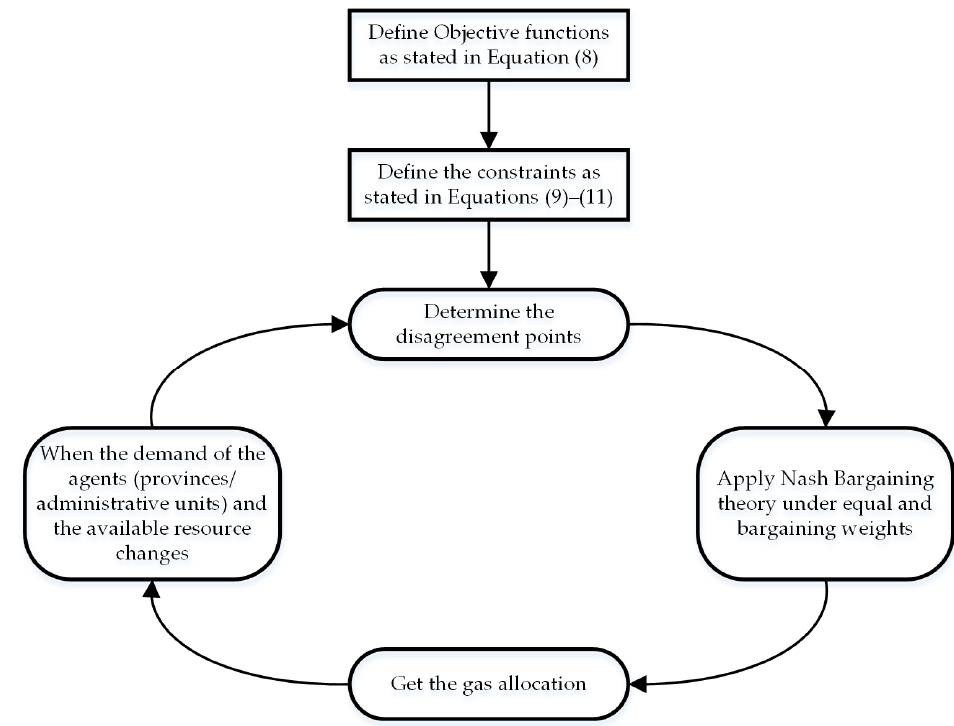
Figure 2. Flow chart for resource allocation under